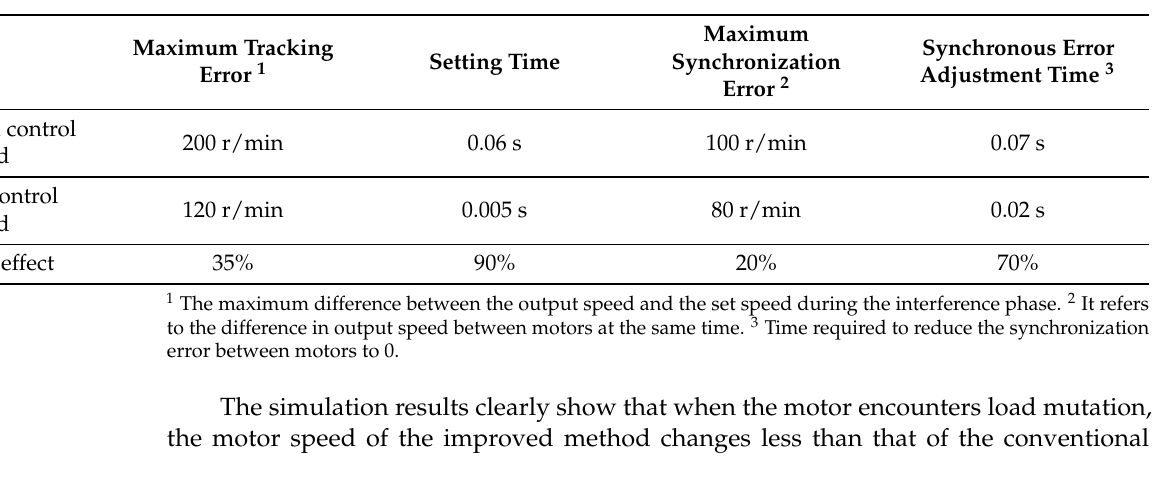
Figure 11. Performance comparison of conventional and improved control methods under sudden load. Table 3. Control system performance